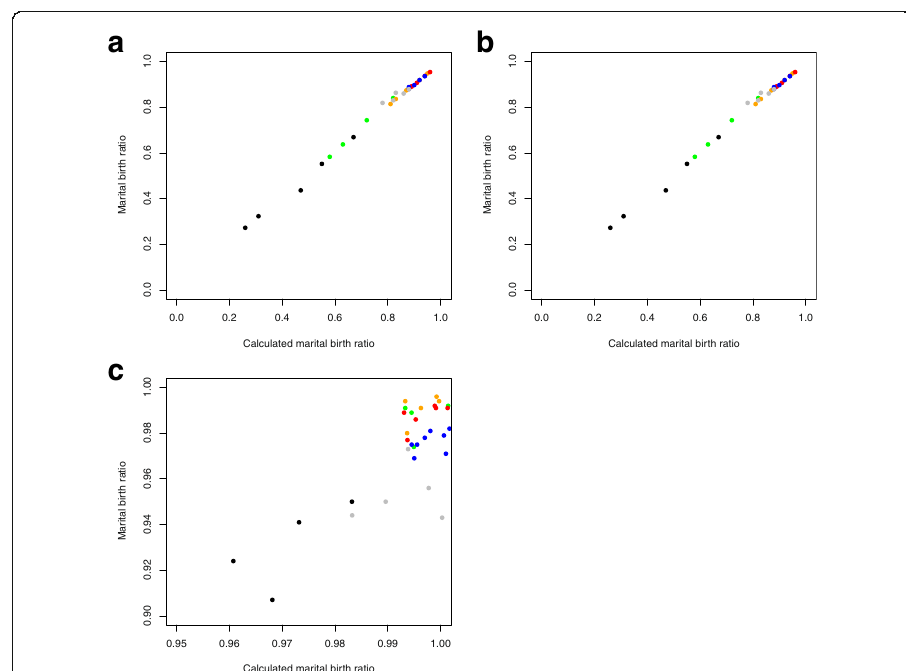
Fig. 2 The marital birth ratio, b w , vs. the calculated marital birth ratio based off marriage and fertility data for all 5-year age groups and years of 1980, 1985, 1990, 1995, and 2000 for two US populations, a African-American women and b White American women. Colors of points indicate the age groups of 15 – 19 (black), 20 – 24 (green), 25 – 29 (orange), 30 – 34 (red), 35 – 39 (blue), and 40 – 44 (gray). R 2 > 0.99 for White American women of all ages and African American women minus the 40 – 44 age group. Inclusion of the possibly erroneous 40 – 44 age group lowers R 2 to 0.73 for African-American women. Note that while R 2 is high for these data as well, they are not directly comparable to Fig. 1 due to aggregation of age groups in Fig. 2 (due to less data) versus a separation of age groups in Fig. 1. They demonstrate that the same relationship holds however both within and between age groups. Data from (Ventura and Bachrach (2000); Martin et al. (2002); National Center for Health Statistics (NCHS) (2006); Martin et al. (2017)). In c , a similar analysis is done for Japanese women with